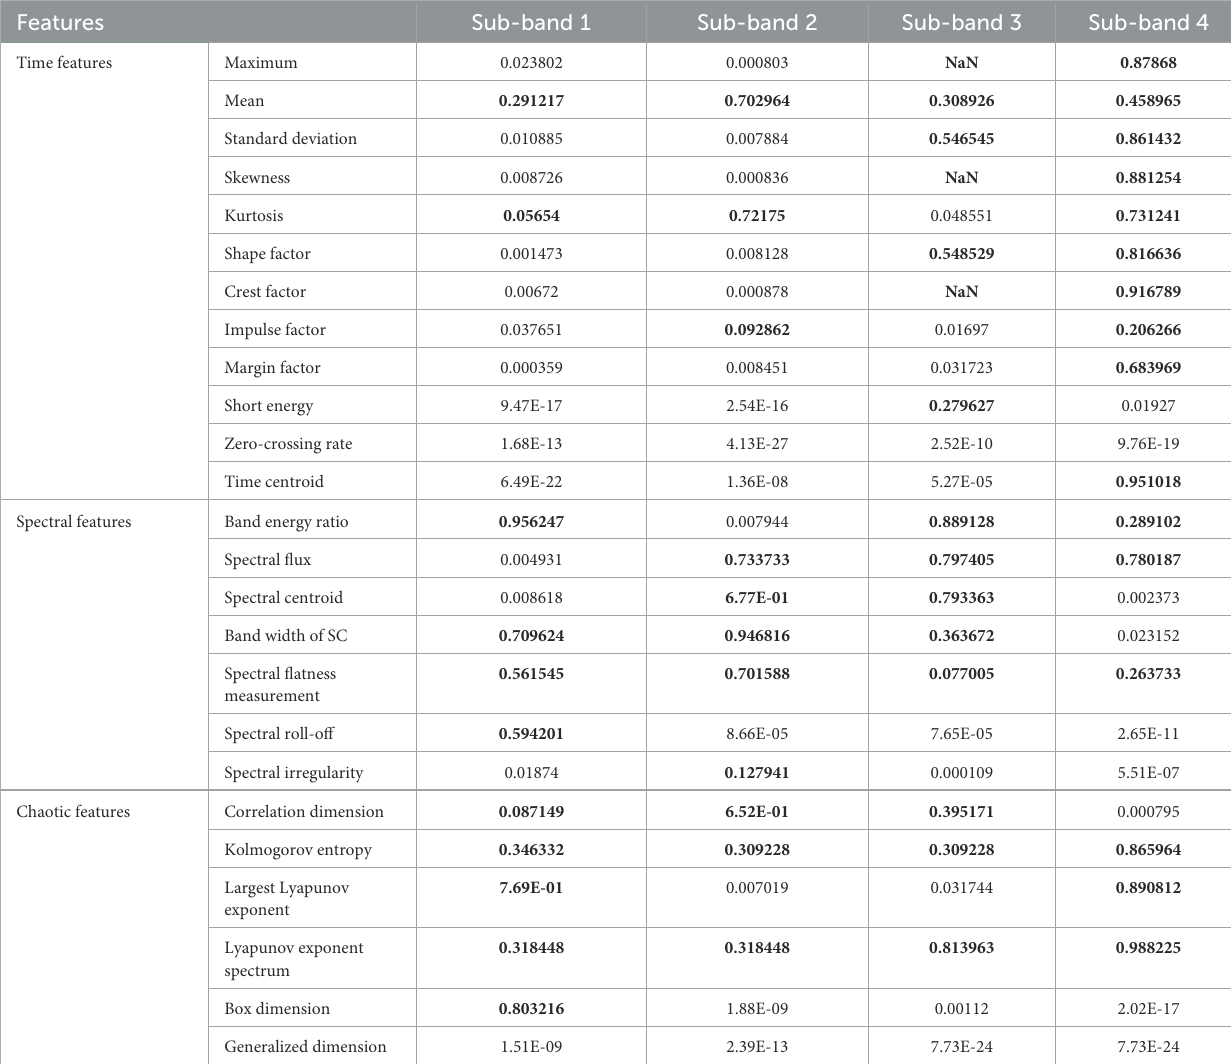
TABLE 3 The P -value of the proposed features computed from various TQWT sub-bands indicates the difference in features between k-complex and